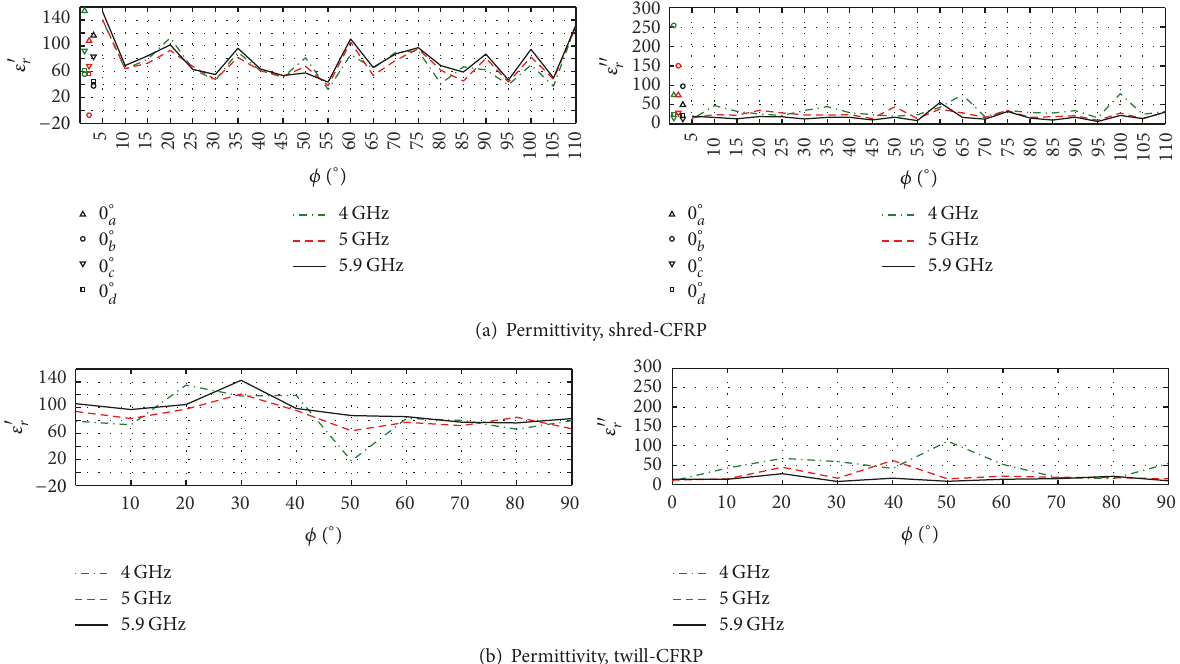
Figure 4: Permittivity of (a) shred-CFRP and (b) twill-CFRP dependent on the orientation of the cut sample.